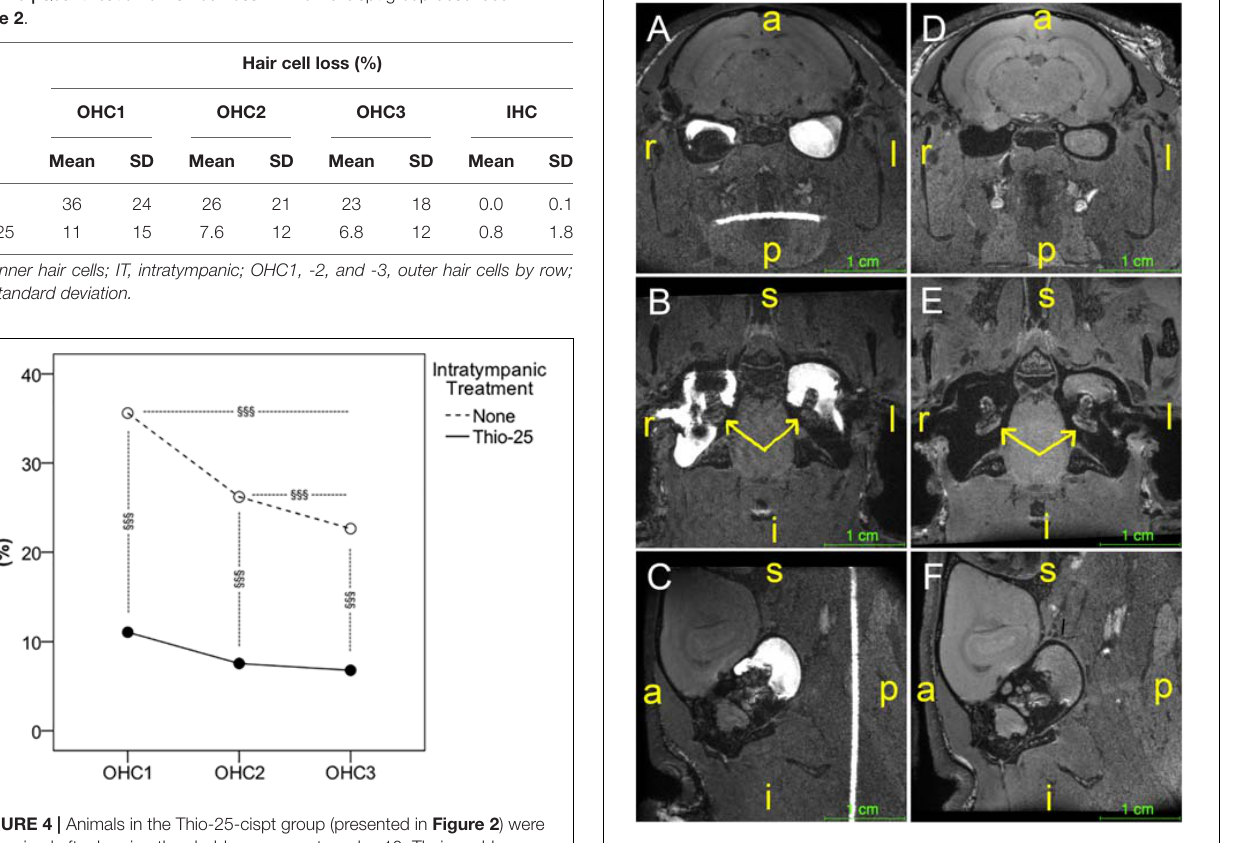
FIGURE 5 | Guinea pigs ( n = 19) were subjected to IT administration of a paramagnetic chitosan-based gel (Chito-Dota) in one ear and a hyaluronan- based gel (Hya-Dota) in the contralateral ear. The gels were then visualized by magnetic resonance imaging. Different orthogonal viewing planes of 3D data from one animal taken immediately after (A–C) and 4 days after (D–F) injection of Chito-Dota into the right ear and Hya-Dota into the left ear. The position of each cochlea is indicated with a yellow arrow in B and E . The sagittal plane in C and F shows the left ear. Keys (in yellow): a, anterior; i, inferior; l, left; p, posterior; r, right; s,